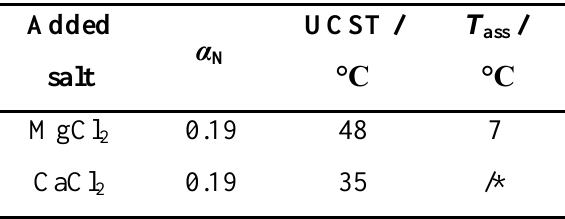
= 0.022 mol L -1 , α p